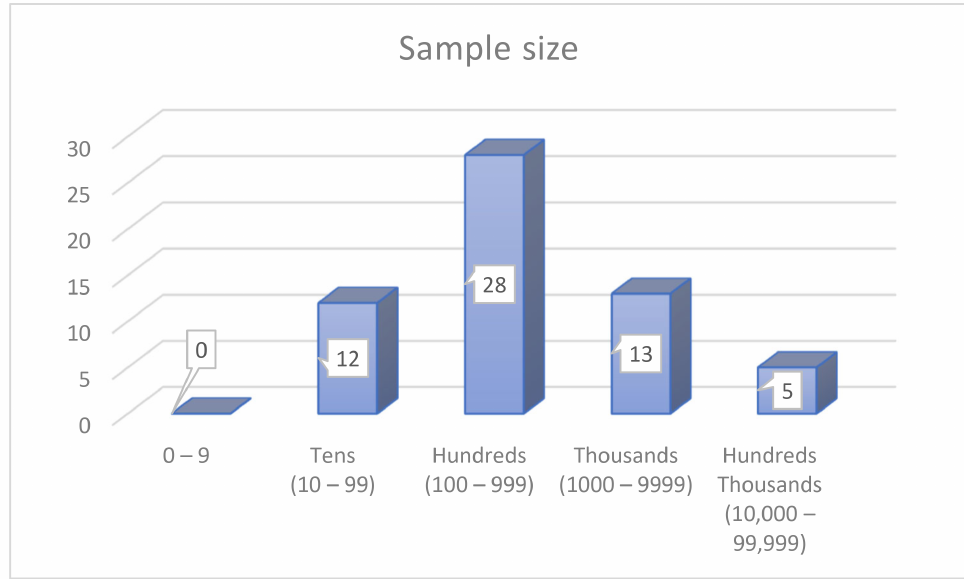
Figure 9. Sample sizes used in studies using social science techniques.